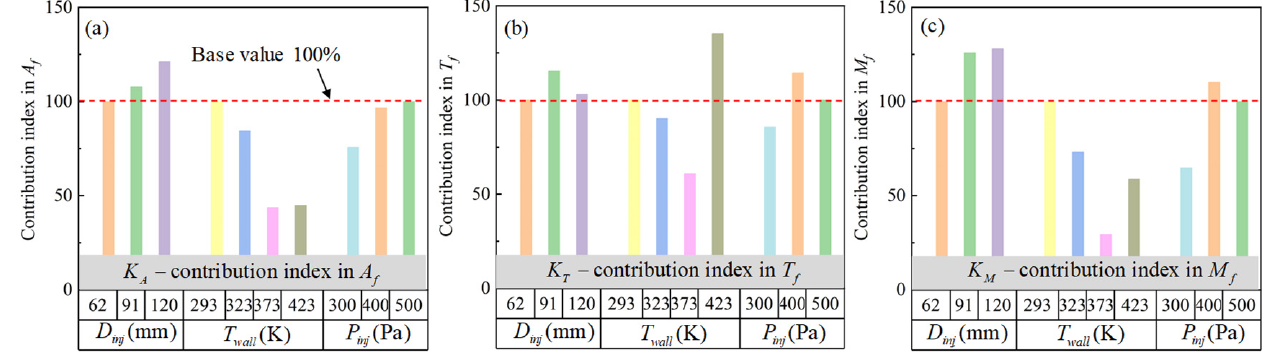
Figure 19. ( a ) Fuel film area A f , ( b ) Fuel film thickness T f and ( c ) Fuel film mass M f on the wall